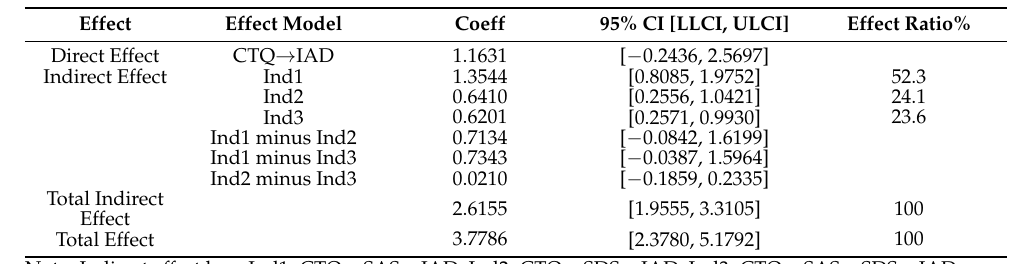
Table 3. The chain-mediated effects of childhood trauma on Internet addiction and bias-corrected 95% confidence